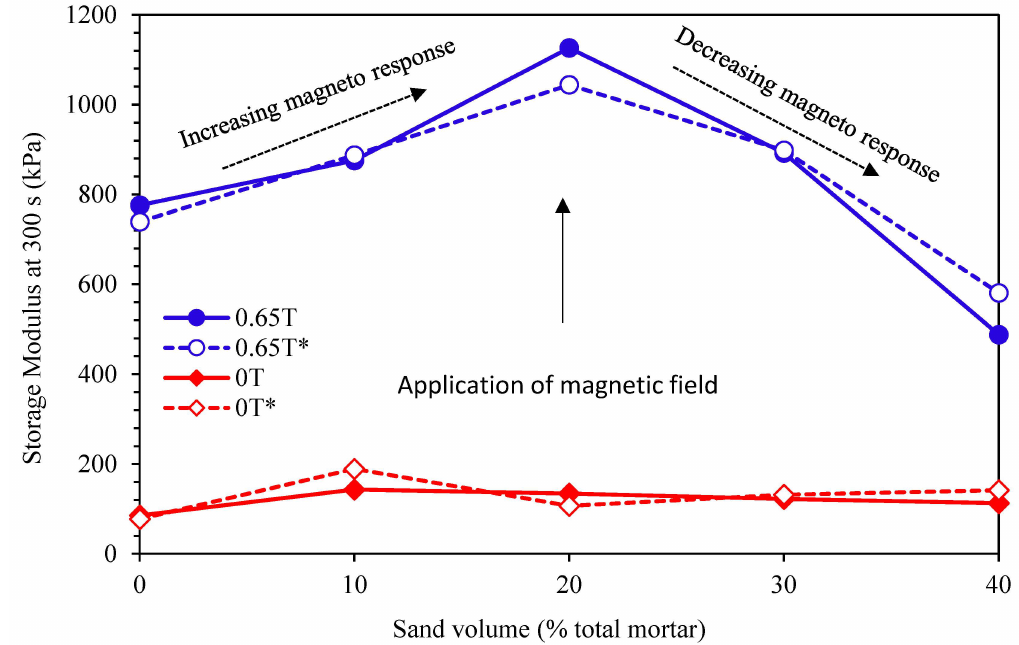
Figure 9. Effect of sand volume fraction on magneto response and increase in storage modulus at 300 s. * Repetition of test on a different